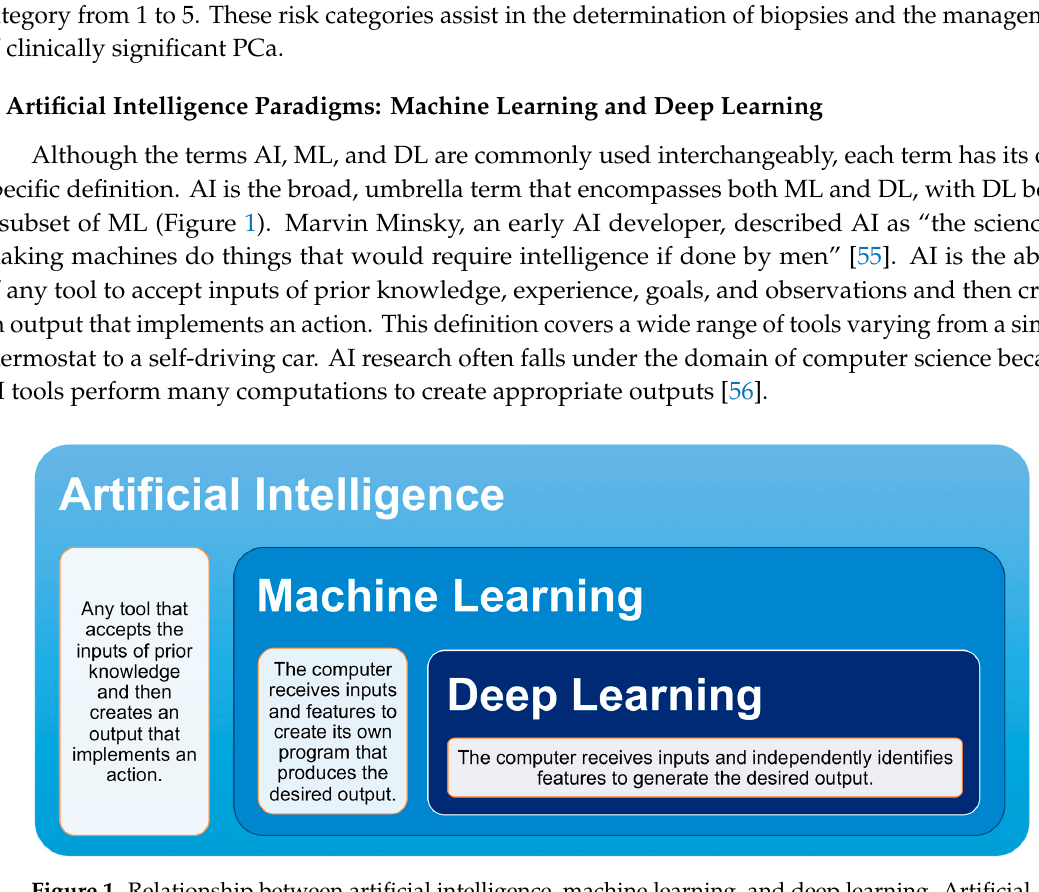
Figure 1. Relationship between artificial intelligence, machine learning, and deep learning. Artificial intelligence is an umbrella term that includes machine learning and deep learning. Deep learning is a hyponym of machine learning.